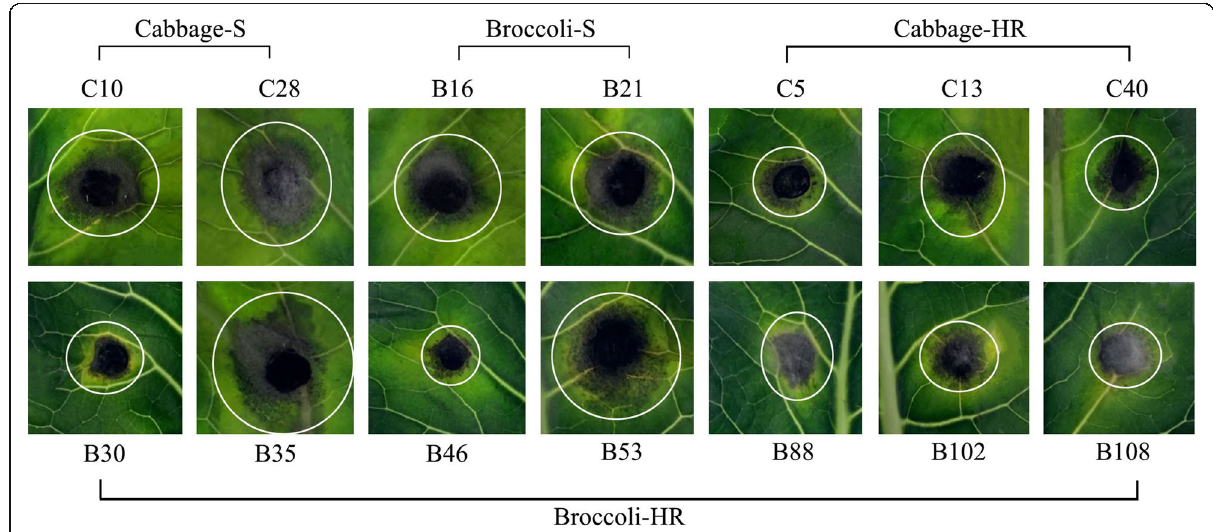
Fig. 2 Virulence analysis of A. alternata Pro S and Pro HR isolates. The tested isolates were inoculated onto broccoli leaves. Disease lesions were determined at 7 days post-inoculation (dpi). The Pro S isolates include C10, C28, B16 and B21. The Pro HR isolates include C5, C13, C40, B30,